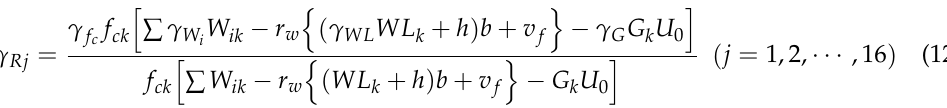
7 of 13 Table 2. Distribution characteristics. Symbol